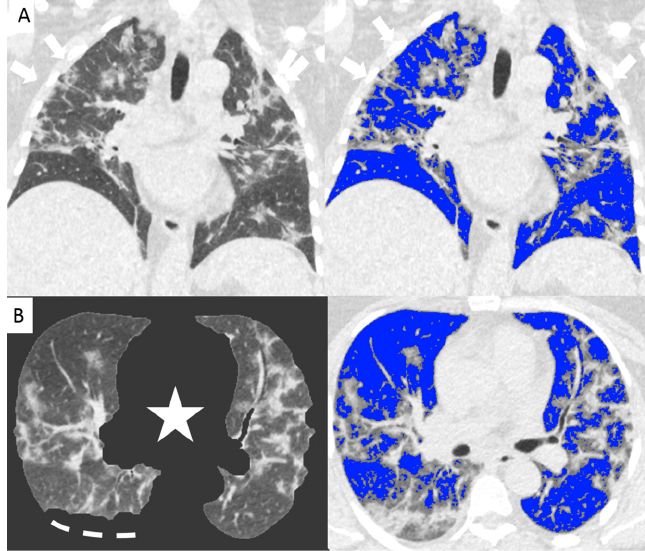
Figure 2. Non-enhanced coronal reconstructions of Chest CT ( A ), (upper panel) showing bilateral ground glass opacities with random distribution and consolidations in the upper and lower lobes (arrows). Lower panel show axial CT reconstructions of the same patient with automatic software segmentation ( B ) excluding all “non-lung” structures, (star) and not evaluable parenchyma due to pleural effusion (segmented line). Images on the right show software evaluation of the well aerated lung (blue) and the infected parenchyma (grey zone, arrows) discriminated by specific threshold. The whole infected volume assessed by software was 47% of the entire lung volume. The patient underwent invasive ventilation.